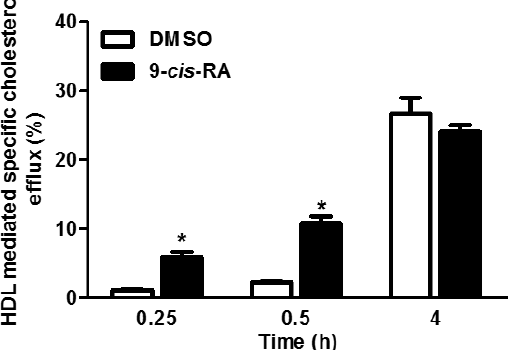
Figure 3. Calibration of different incubation periods with High-Density Lipoprotein (HDL). Peritoneal macrophages isolated from C57BL/6 mice were treated for 24 h with or without vehicle (DMSO) or 2 µM of 9- cis -retinoic acid (RA). Cells were labeled with 0.5 µCi/mL 3 H-cholesterol in serum-free Dulbecco’s Modified Eagle Medium (DMEM). Cholesterol efflux was determined after 0.5, 1, and 4 h incubation with 1 µg/mL HDL. The results are expressed as mean ± SE of one experiment performed in triplicate.* p < 0.05.